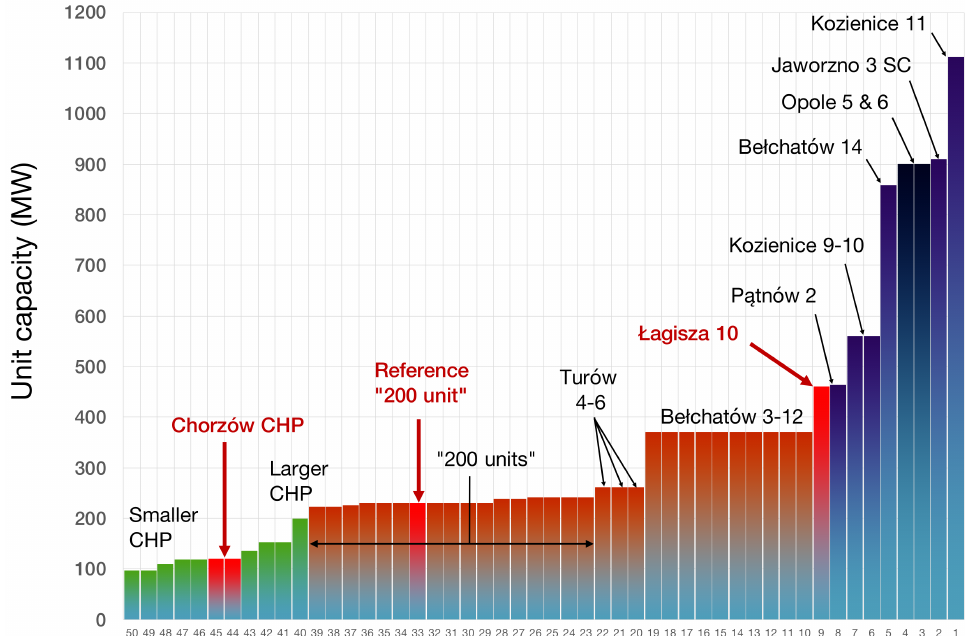
Figure 6. Categorization of the 50 largest modern or modernized coal power units in